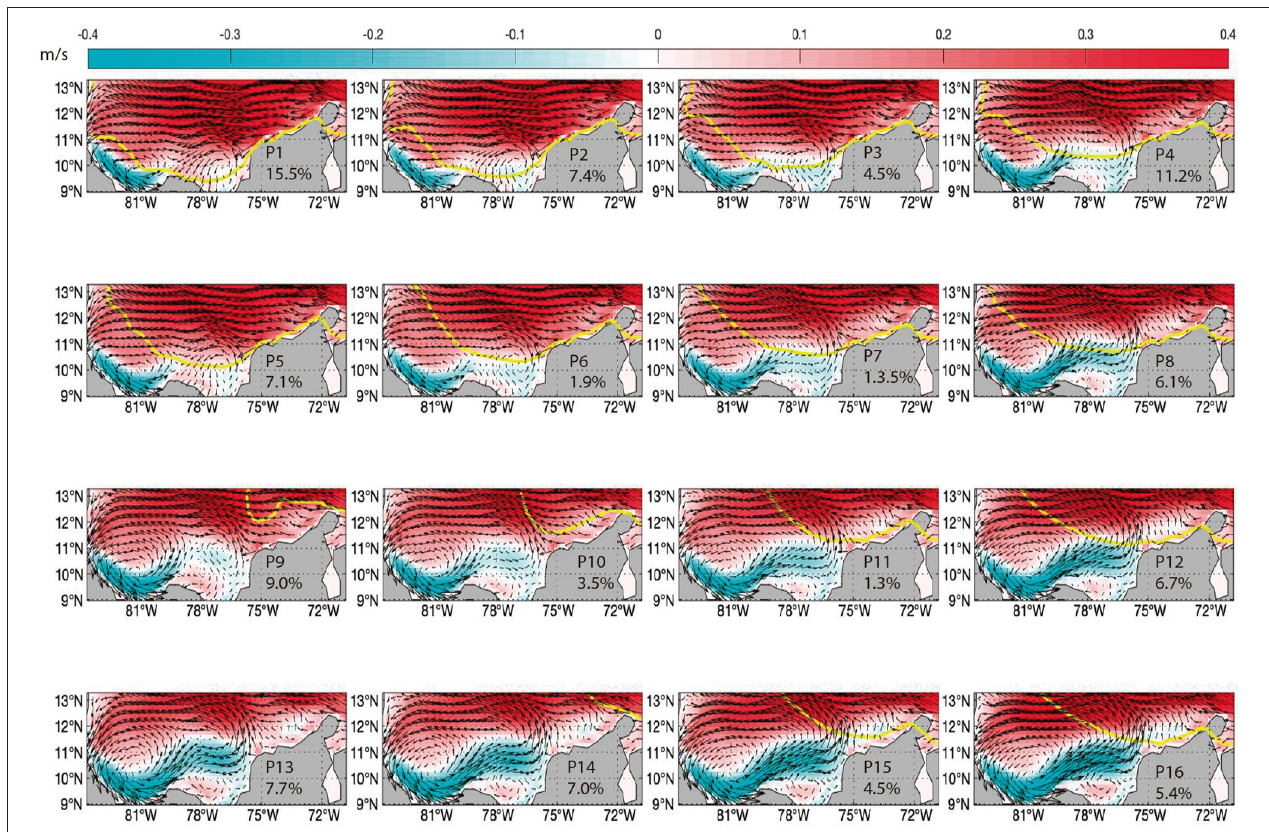
FIGURE 8 | Spatial patterns of surface currents given by a 4 × 4 SOM analysis in the Caribbean Sea computed from weekly mean surface velocities over the time period 2007–2012. The colorbar indicates the magnitude of the zonal velocity in m · s − 1 (note that positive values are westwards). Yellow line indicates the corresponding 8 m · s − 1 wind contour as obtained from the wind SOM patterns ( Figure 9 ). Each panel shows the probability of